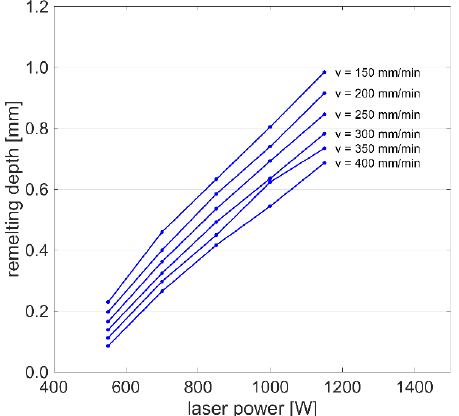
Figure 8. Correlation of remelting width and depth for the simulation results of the heat conduction model with the fit, according to Equation (10).